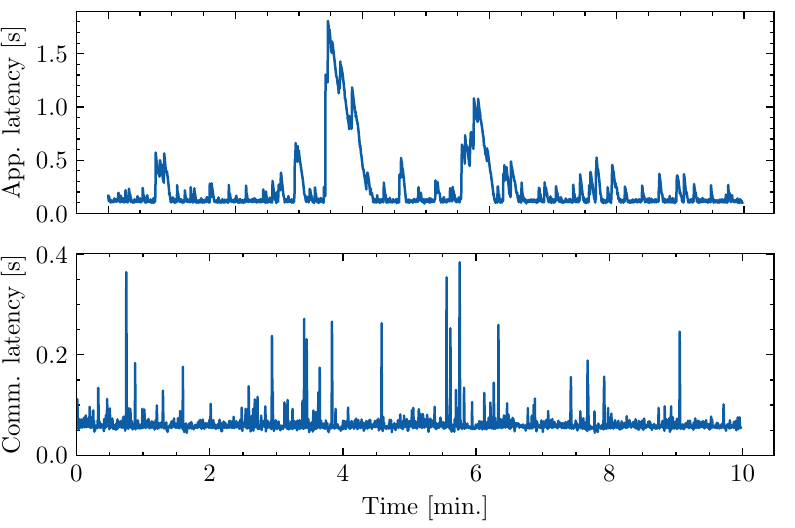
Figure 6. When peaks in the communication latency occur, the application latency tends to increase quickly right after. Consequently, we can state that the variability in application latency is mostly dependent on the connectivity between the edge device and the